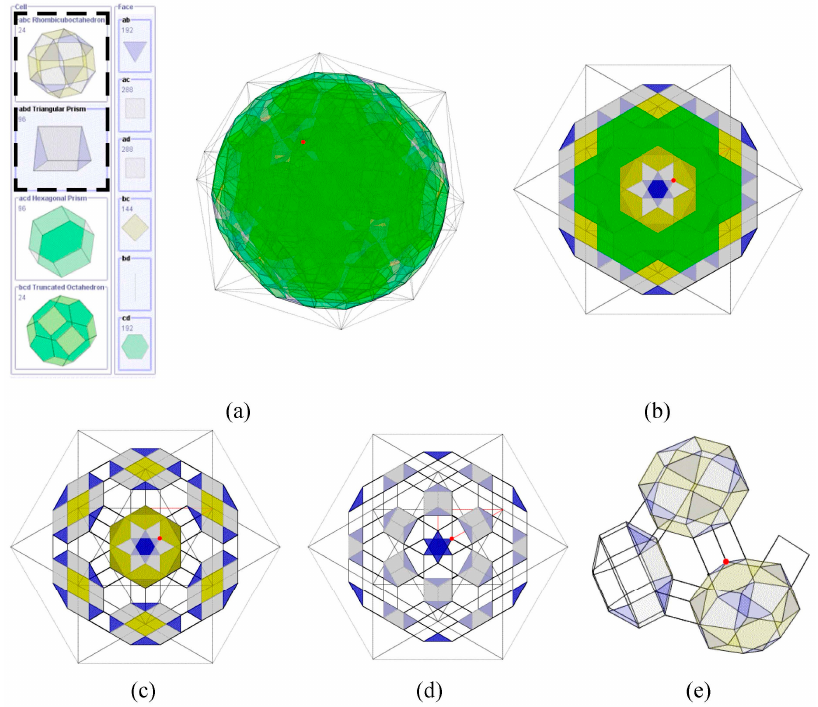
Figure 10. Complementary interactions being applied to a visualized 4D object. The original state of the object ( a ); the result of stacking ( b ); the result of filtering a subset of 3D cells ( c ); the result of filtering a different subset of 3D cells ( d ); the result of unstacking and focus+scoping interactions ( e ); together the interactions help confirm a hypothesis about the shape.